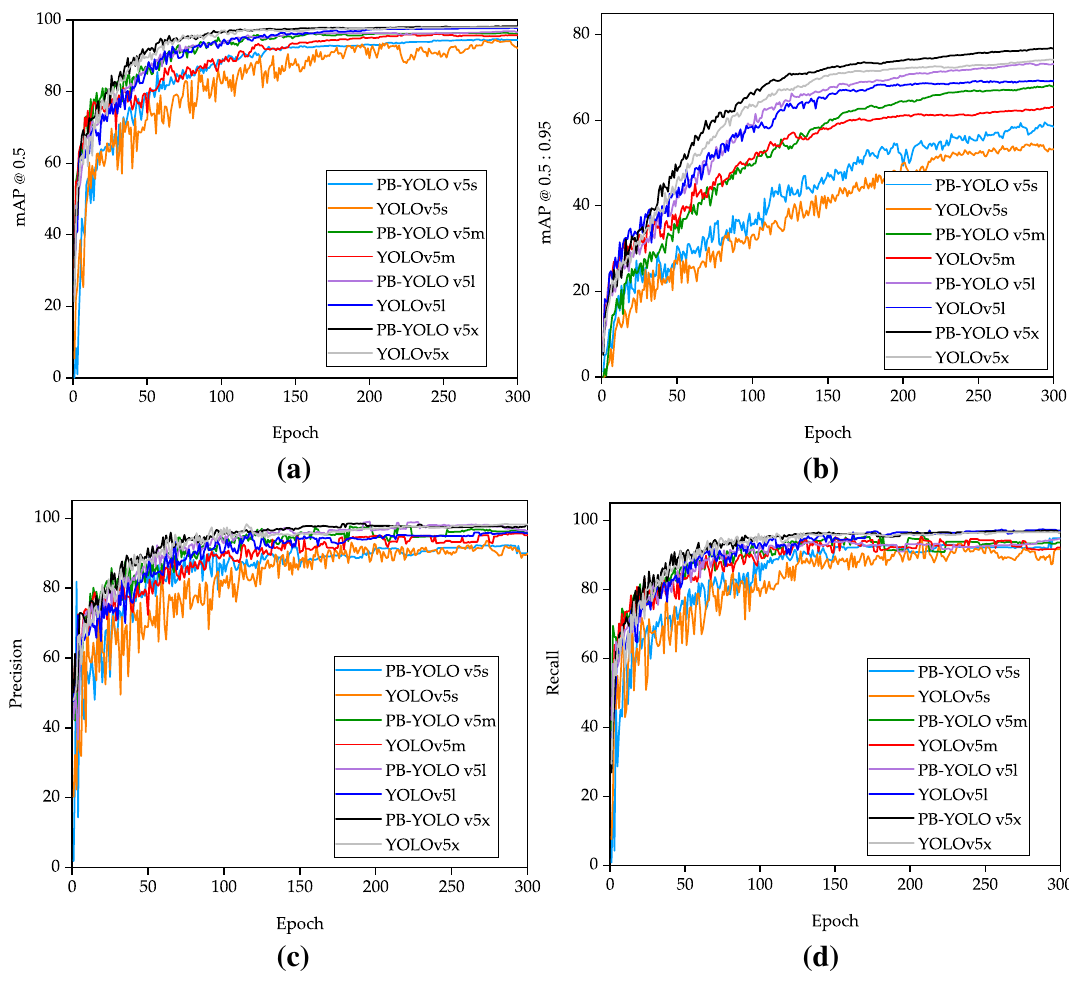
Figure 10. Comparison of evaluation indexes under different models: ( a ) mAP@.5 curve, ( b ) mAP @.5:.95 curve, ( c ) Precision curve, ( d ) Recall curve.